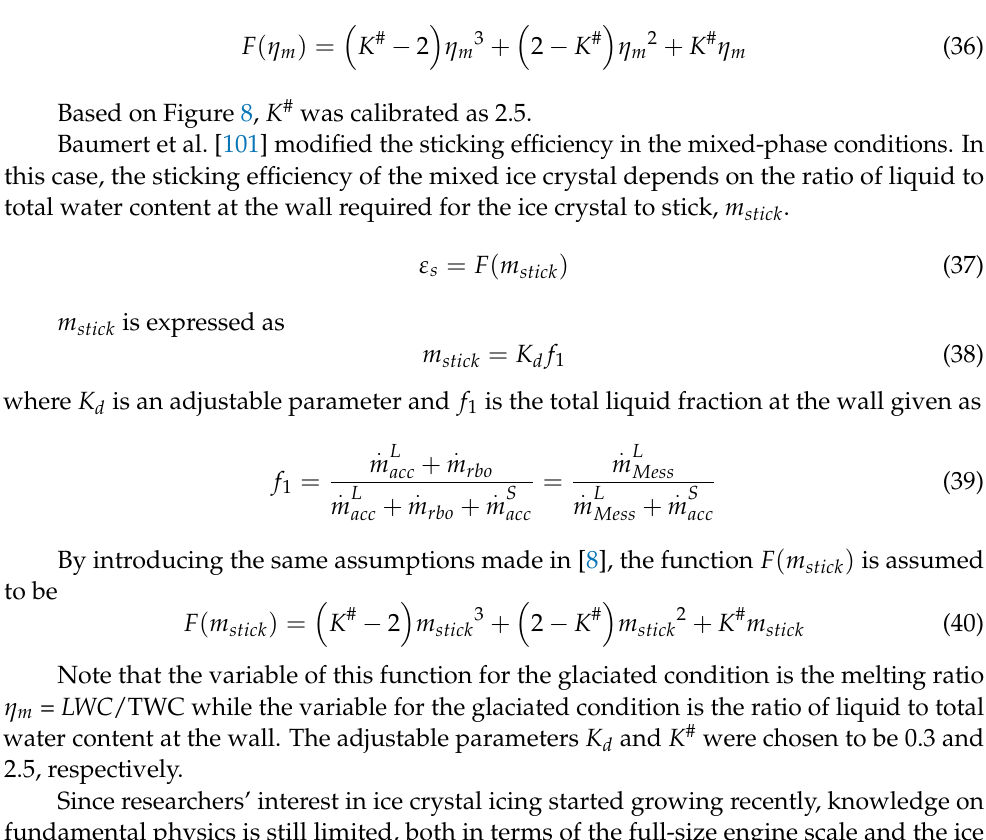
Figure 8. Relation between the melting ratio and sticking efficiency (obtained from [96]). They expressed the function as polynomials.